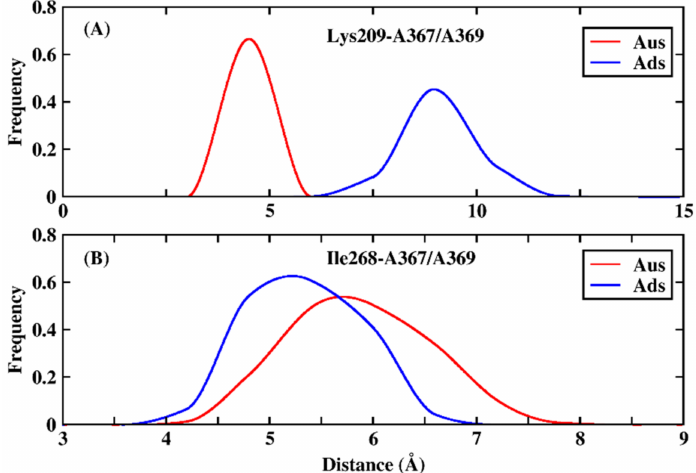
Figure 4. The distribution of distance for key residue Lys209 and Ile268 in Ads and Aus system. ( A ) the distance between the charged group of Lys209 and the phosphate group of adenine nucleotide A367 of Aus and A369 of Ads system. ( B ) distance between the alkyl of residue Ile268 and the hydrophobic ring of adenine nucleotide A367 of Aus and A369 of Ads system.